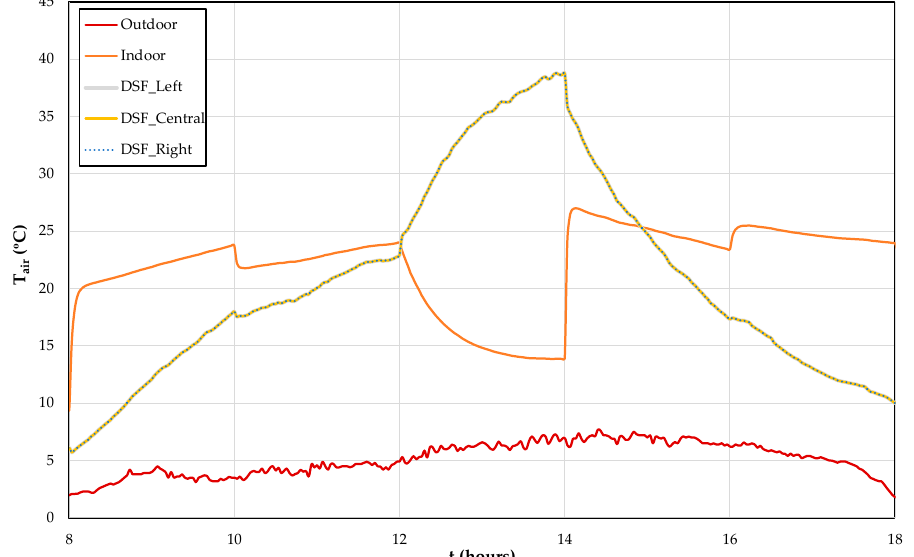
Figure 16. Evaluation of air temperature (T air ) of the outdoor environment, indoor virtual chamber and indoor left, central and right DSF system, when the airflow rate is variable and the number of DSFs to operate is constant, for the Case D.